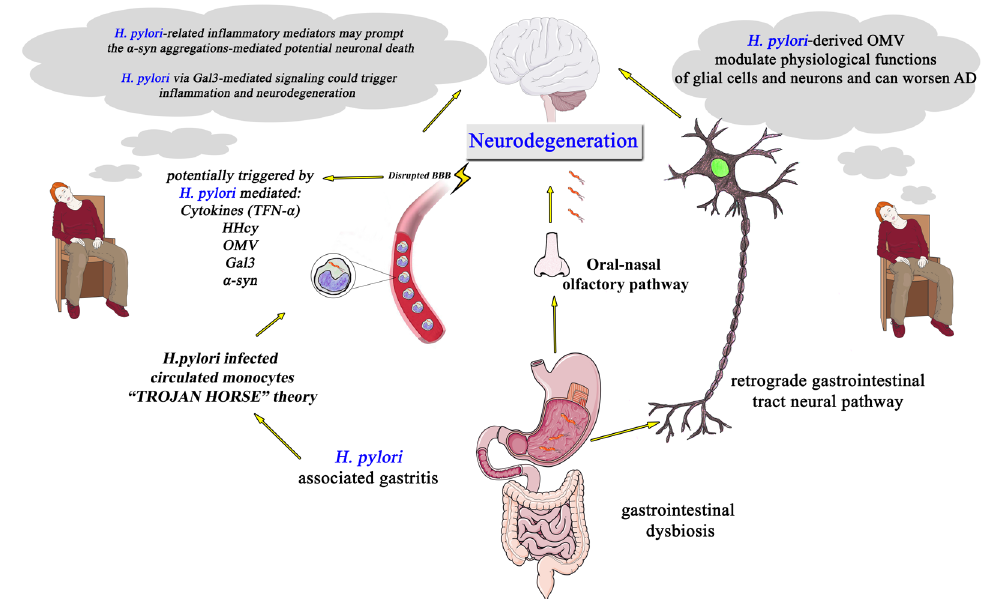
Figure 1. Schematic illustration of proposed pathophysiological pathways connecting Helicobacter py- lori infection and neurodegeneration. AD, Alzheimer’s disease; α -syn, α -synuclein; BBB, blood–brain barrier; Gal-3, Galectin-3; H. pylori, Helicobacter pylori ; HHcy, hyperhomocysteinemia; OMV, outer membrane vehicles; TNFα, tumor necrosis factor - α.